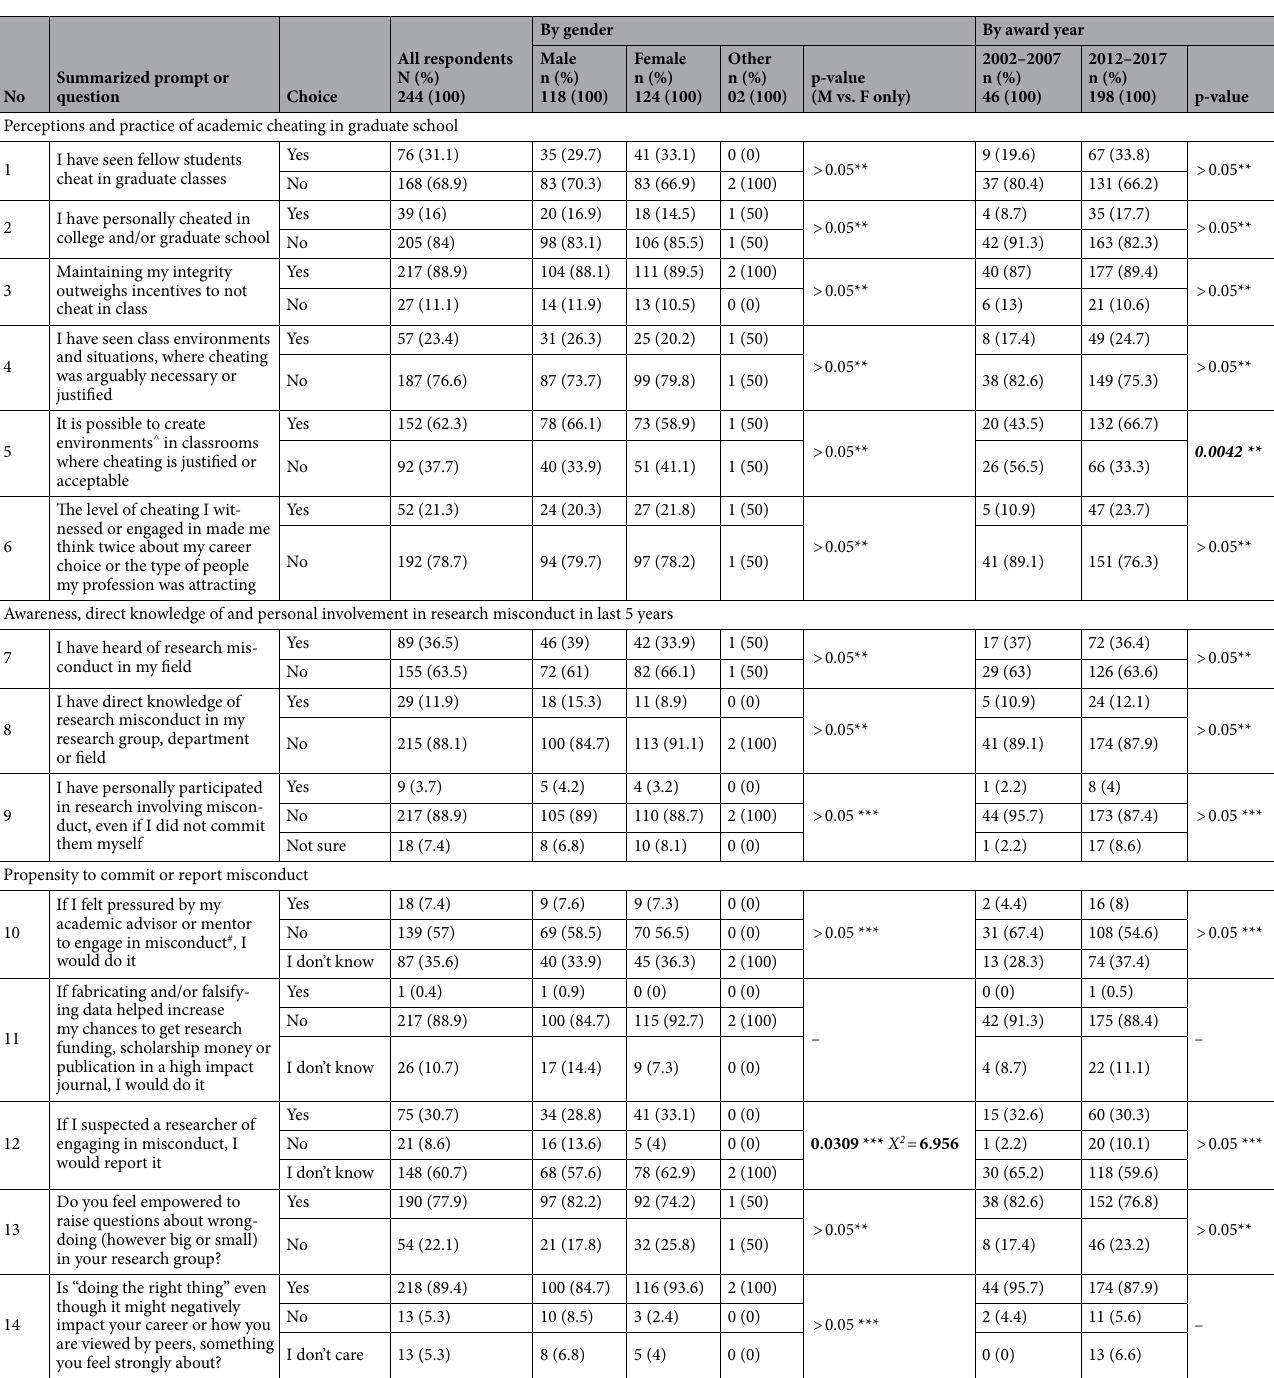
Table 3. Academic cheating and research misconduct. NSF Fellows’ perceptions and practice of academic cheating in graduate school (Q1–6), awareness, direct knowledge of and personal involvement in research misconduct in last five years (Q7–9), and propensity to commit or report misconduct (Q10–14). Percentages may not add up to 100 because of rounding. ^ e.g., poor design of classes, hypercompetitive grading, unfair homework practices. # Examples given in prompt: “everyone is doing it this way”, “it is okay to throw out